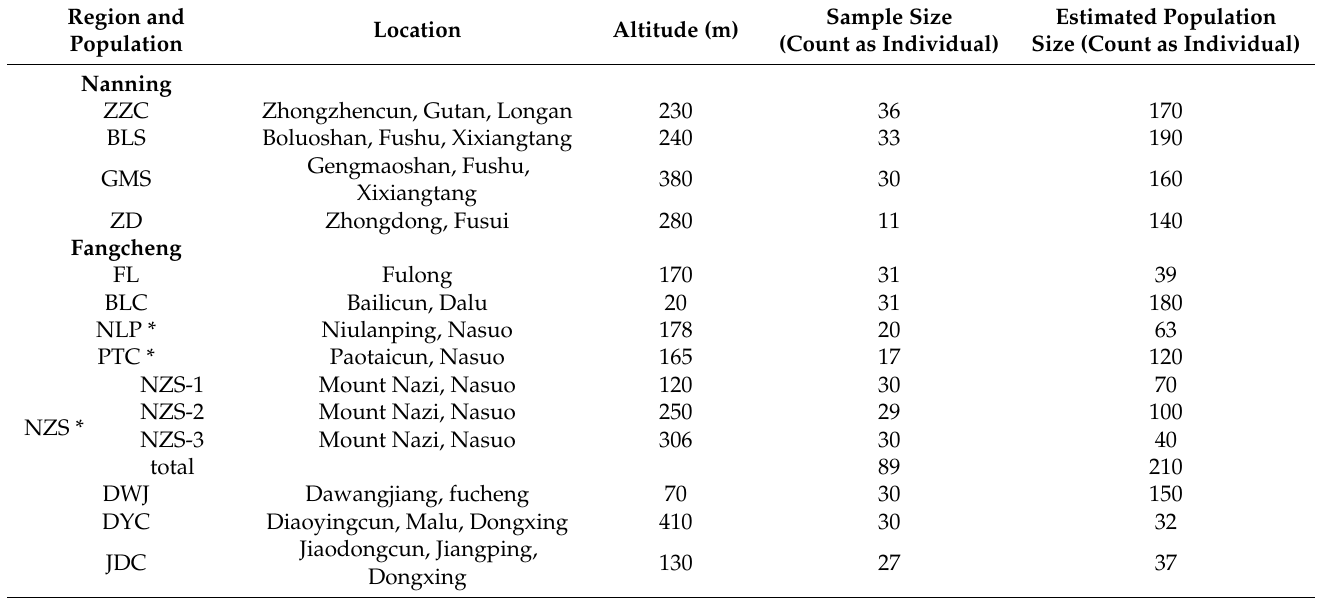
Table 1. Details of remnant populations of Camellia nitidissima in South